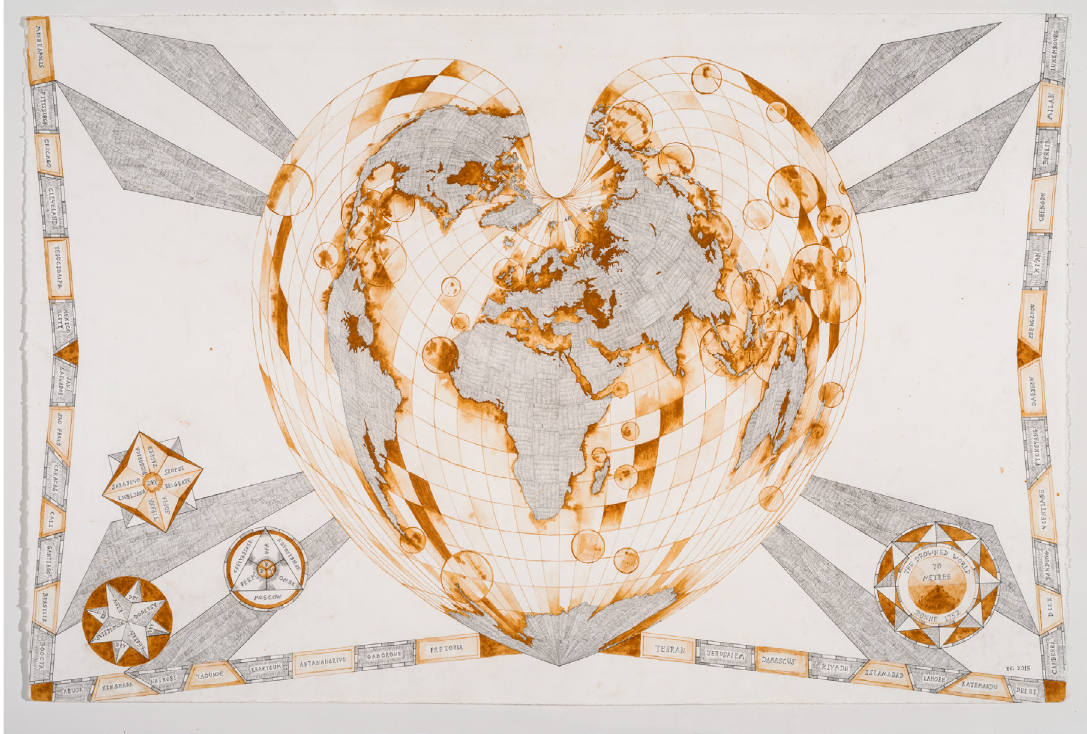
Figure 7: Tracey Clement, Drowned World : Bonne Projection , 2015, pencil and rust on paper, 80 x 121